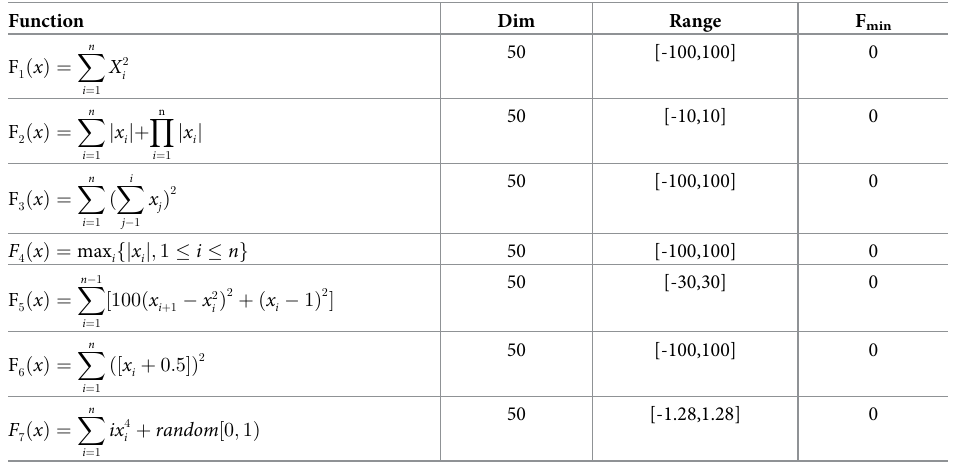
Table 1. Unimodal benchmark